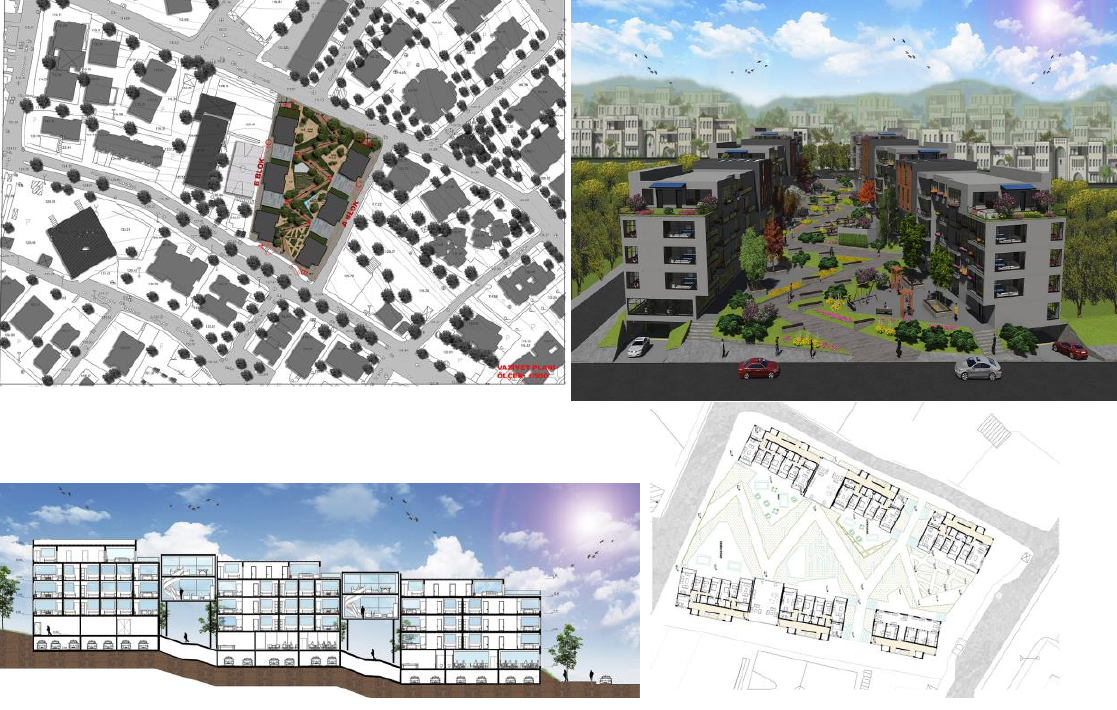
Figure 1. Muhammet Yusuf Birinci - Activity